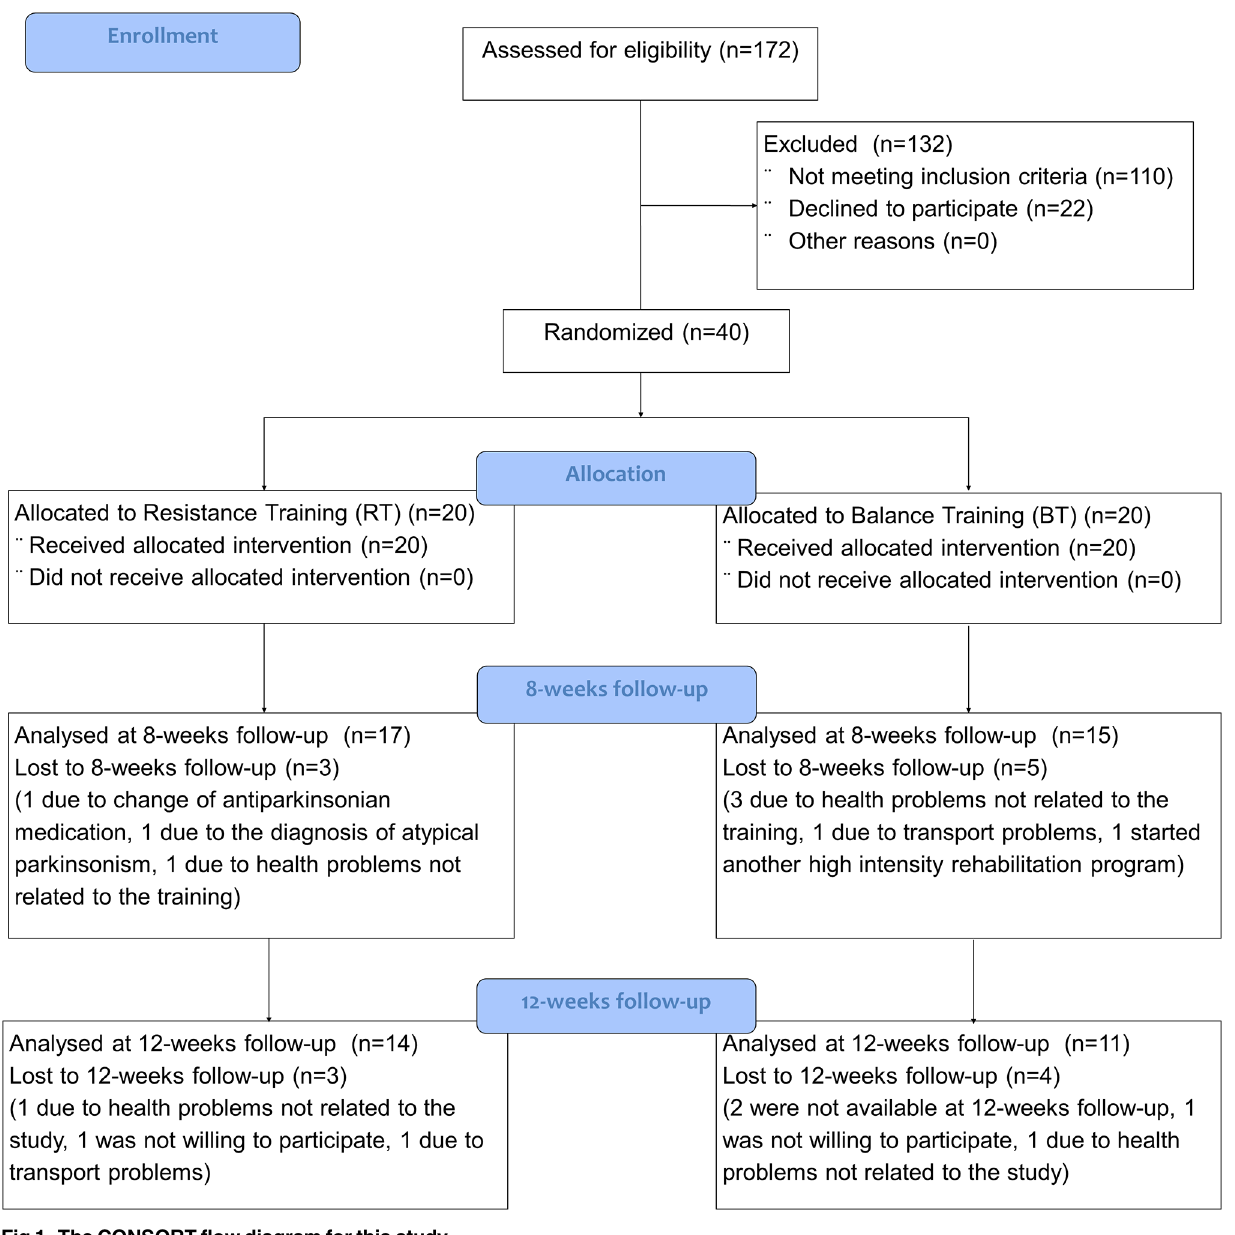
Fig 1. The CONSORT flow diagram for this